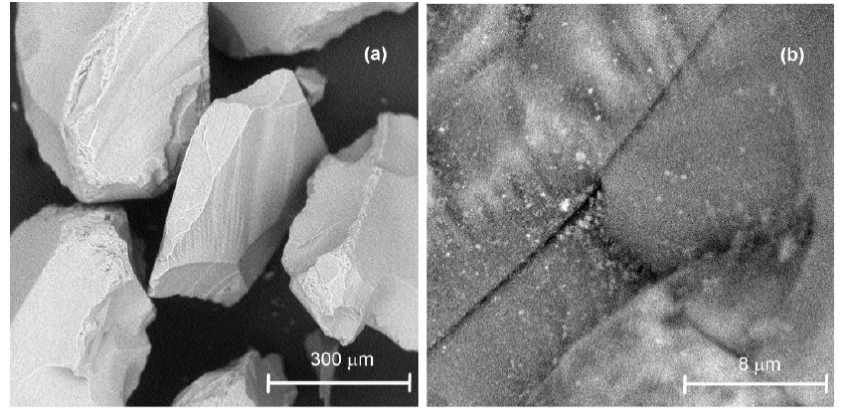
Figure 5. Micrographs of APTES10 sample: ( a ) Magnification 290×; ( b ) Magnification 10,000×.